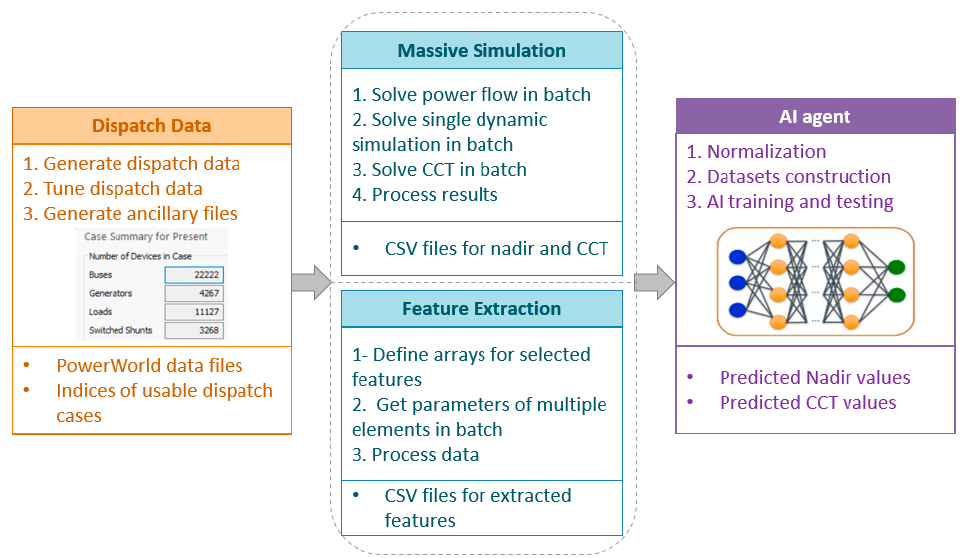
Figure 6. The overall structure of the technical approach.